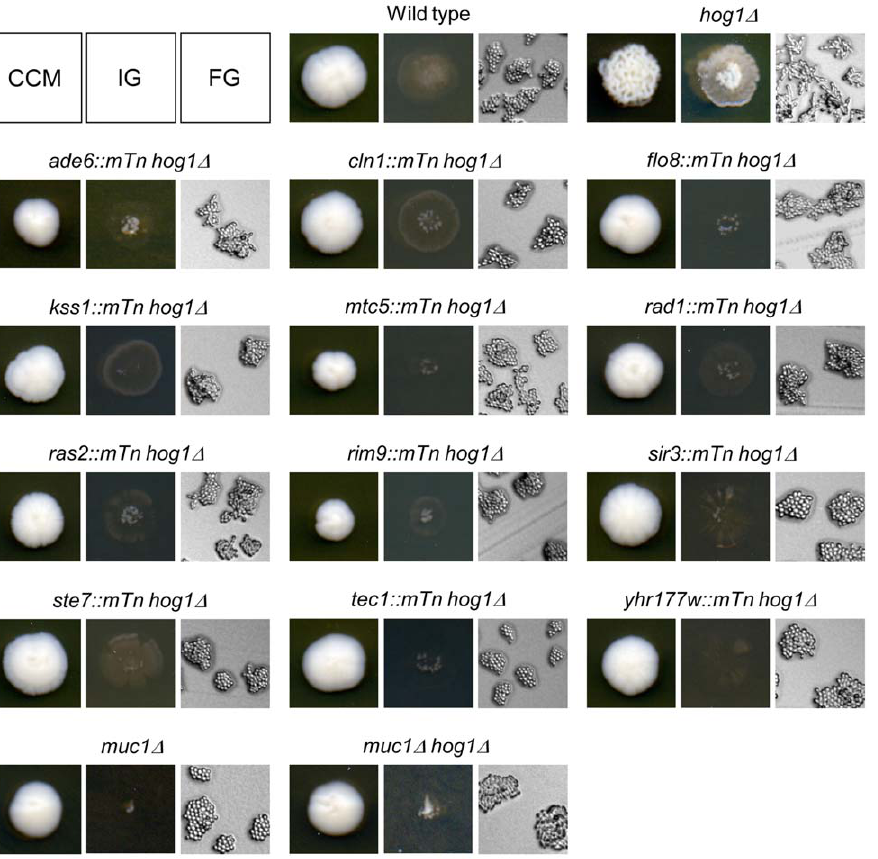
Figure 4. Morphological assay of homozygous double mutant strains which suppress enhanced morphological developments of hog1 D /hog1 D . CCM: complex colony morphology, IG: invasive growth, FG: filamentous growth. All other suppressor mutants identified are shown in Table 1.